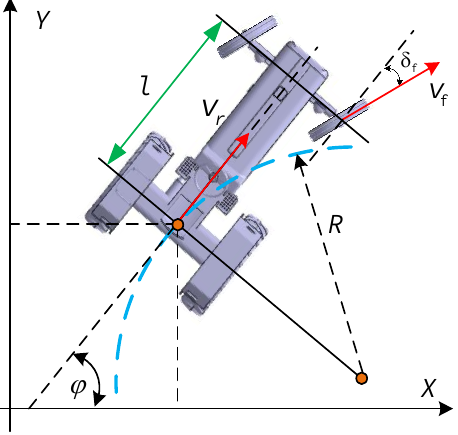
Figure 1. Single-track kinematic model of a wheeled tractor.